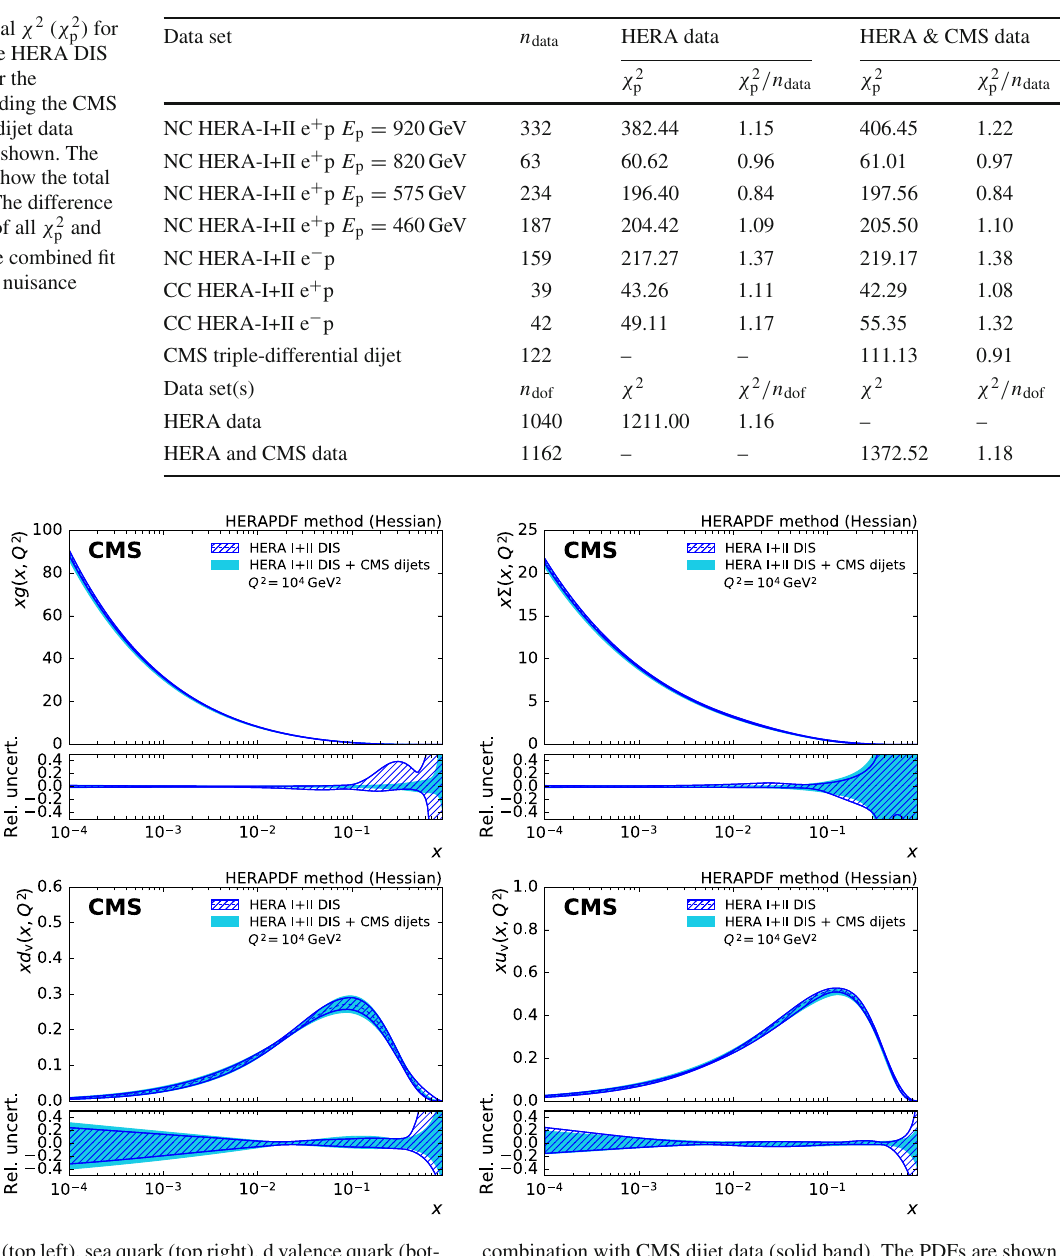
The PDFs obtained for the gluon, u valence, d valence, and sea quarks are presented for a fit with and without the CMS dijet data in Fig. 9 for Q 2 = 10 4 GeV 2 . The uncertainty in the gluon PDF is reduced over a large range in x with the largest impact in the high- x region, where some reduction in uncertainty can also be observed for the valence quark and the sea quark PDFs. For x values beyond ≈ 0 . 7 or below 10 − 3 , the extracted PDFs are not directly constrained by